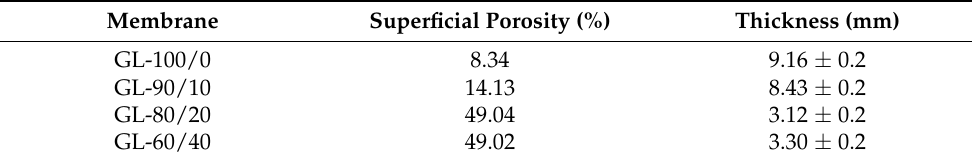
Table 2. Polymeric membranes characteristic: superficial porosity and thickness.